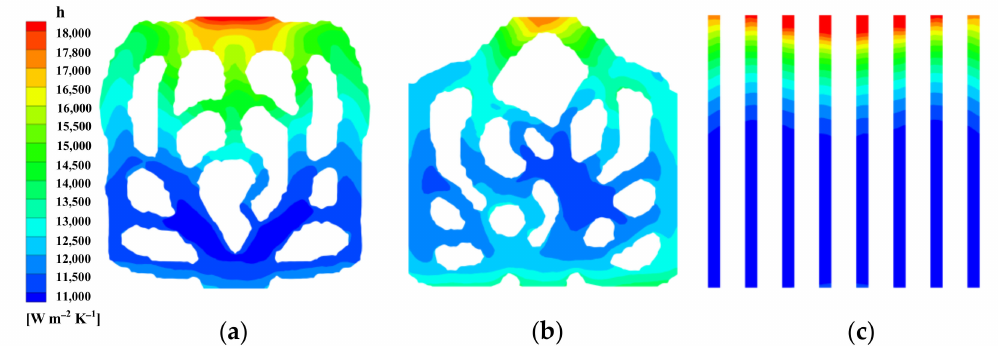
Figure 12. Contours of the surface heat transfer coefficient for u f in = 0.7 m/s and q = 40 W/cm 2 .